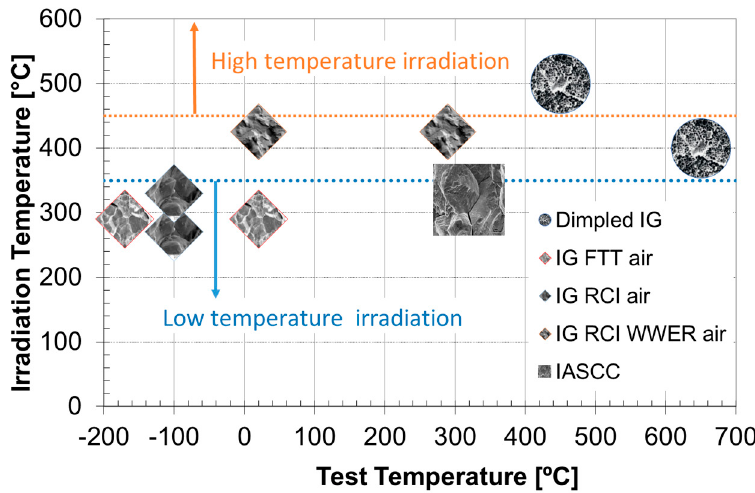
Figure 15. The irradiation vs. test temperature schematic showing the occurrence of IG fracture in neutron irradiated ASSs, as referred to in [3,9,14,16–20,32–35]. Blue and orange dotted horizontal lines separate the low, intermediate and high temperature irradiation areas. IG is intergranular, FTT is Flux thimble tube, RCI is Reactor Core Internals, IASCC is Irradiation Assisted Stress Corrosion Cracking.